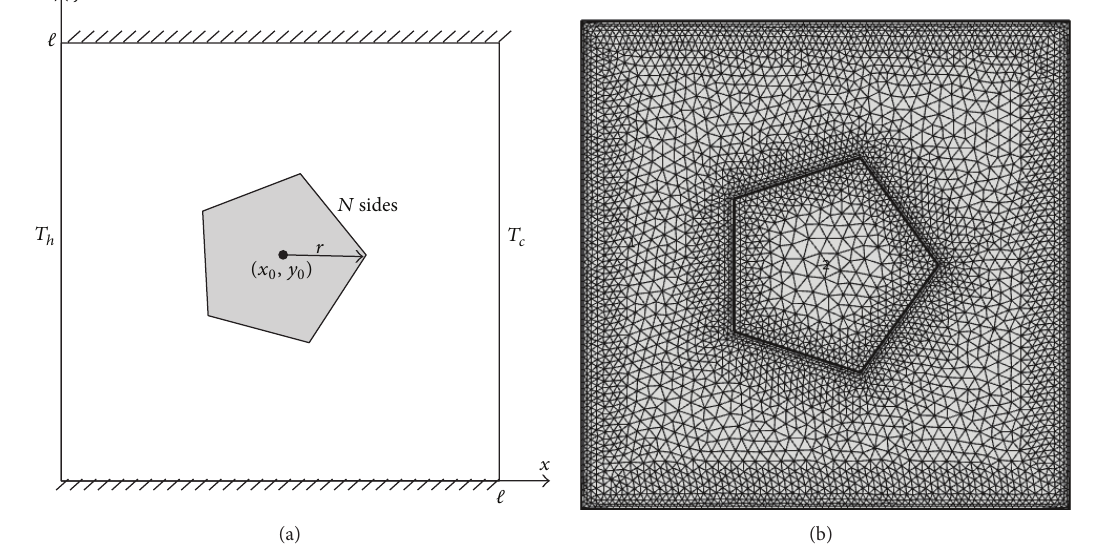
Figure 1: (a) Schematic representation of the model. (b) Mesh